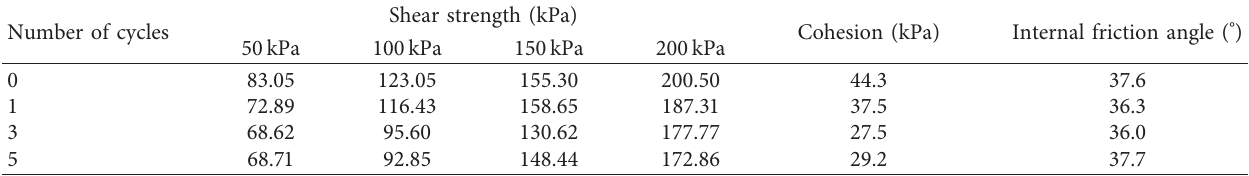
Table 4: Results of the direct shear test for compacted loess